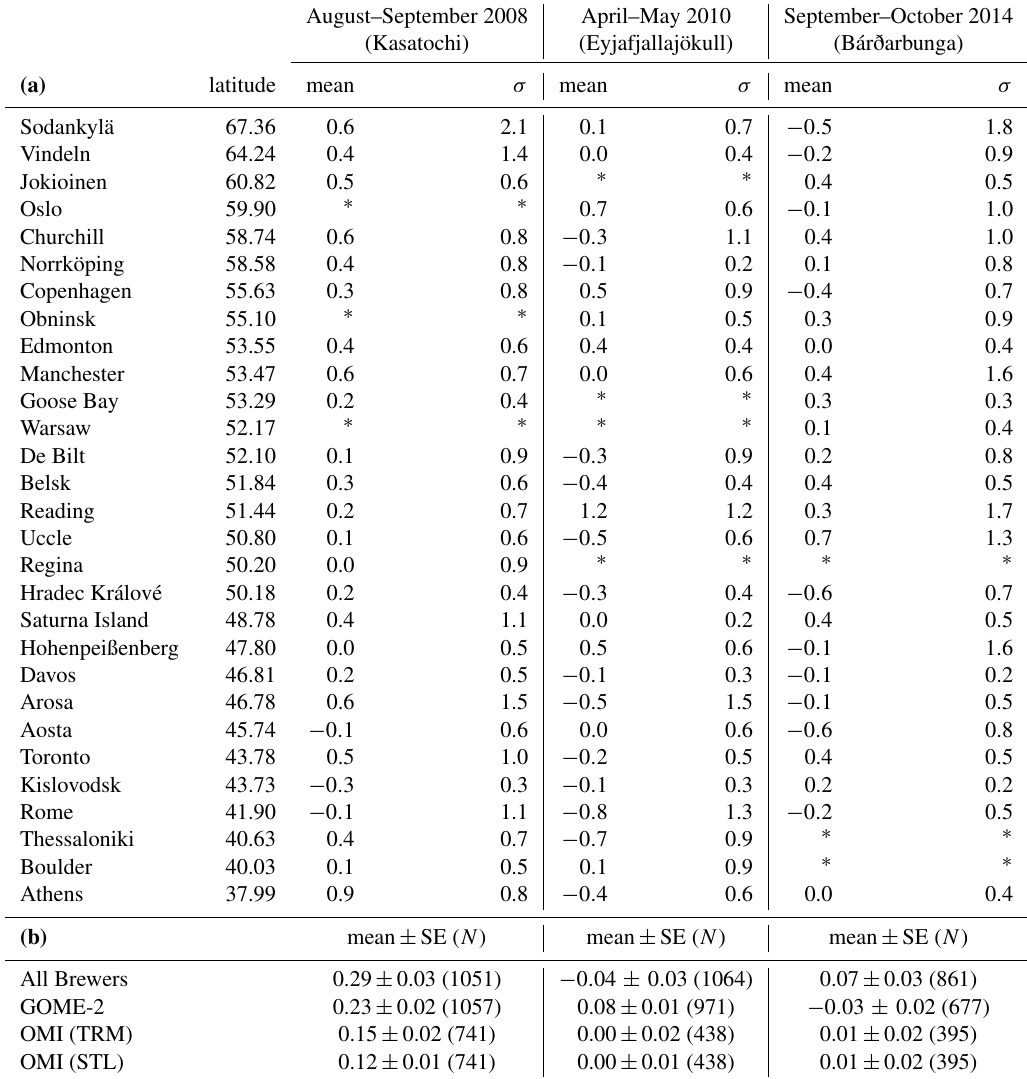
Table 4. SO 2 column departures at midlatitude stations averaged in bimonthly periods following volcanic